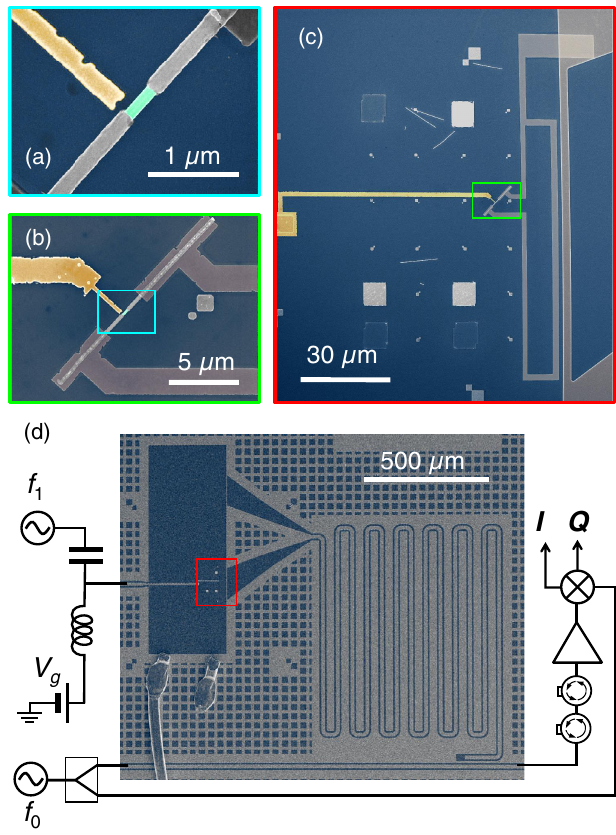
FIG. 4. Experimental setup. (a) False-color scanning-electron- microscope image of the InAs-Al core-shell nanowire. The Al shell (gray) is removed over 370 nm to form the weak link between the superconducting electrodes. A close-by side electrode (Au, yellow) is used to gate the InAs exposed region (green). (b),(c) The nanowire is connected to Al leads that form a loop. This loop is located close to the shorted end of a coplanar wave-guide (CPW) resonator. (d) The CPW resonator is probed by sending through a bus line a continuous microwave tone at its resonant frequency f 0 ¼ 3 . 26 GHz and demodulating the transmitted signal, yielding quadratures I and Q . Microwaves inducing Andreev transitions are applied through the side gate (frequency f 1 ) using a bias tee, the dc port being used to apply a dc voltage V g